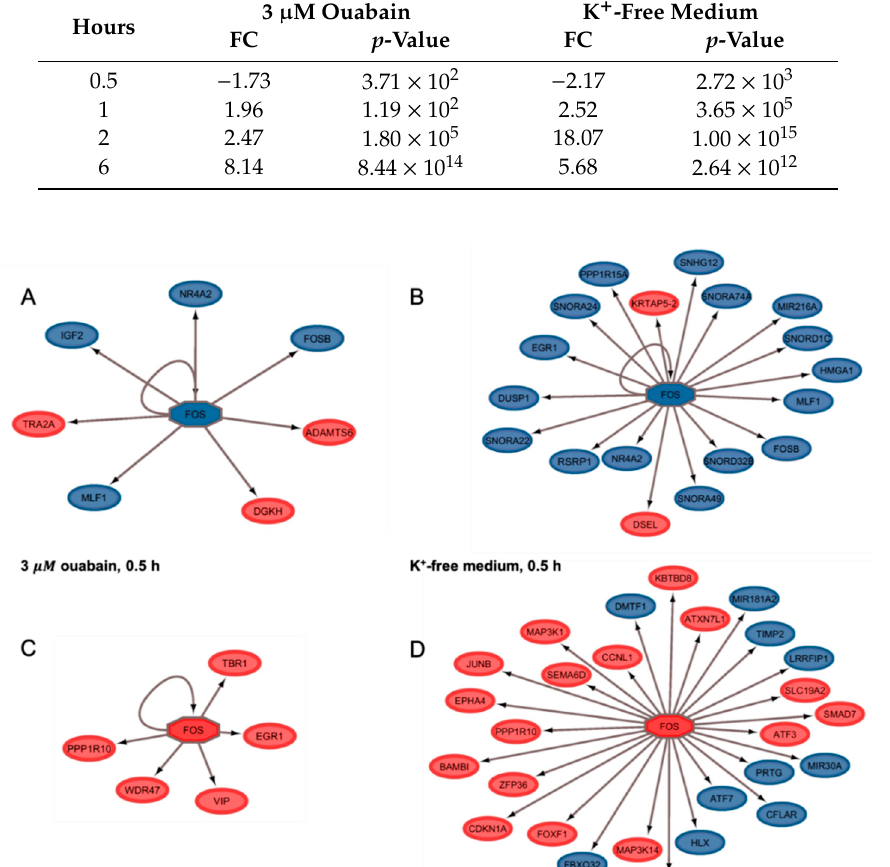
Table 5. Kinetics of FOS gene expression triggered by Na,K-ATPase inhibition.